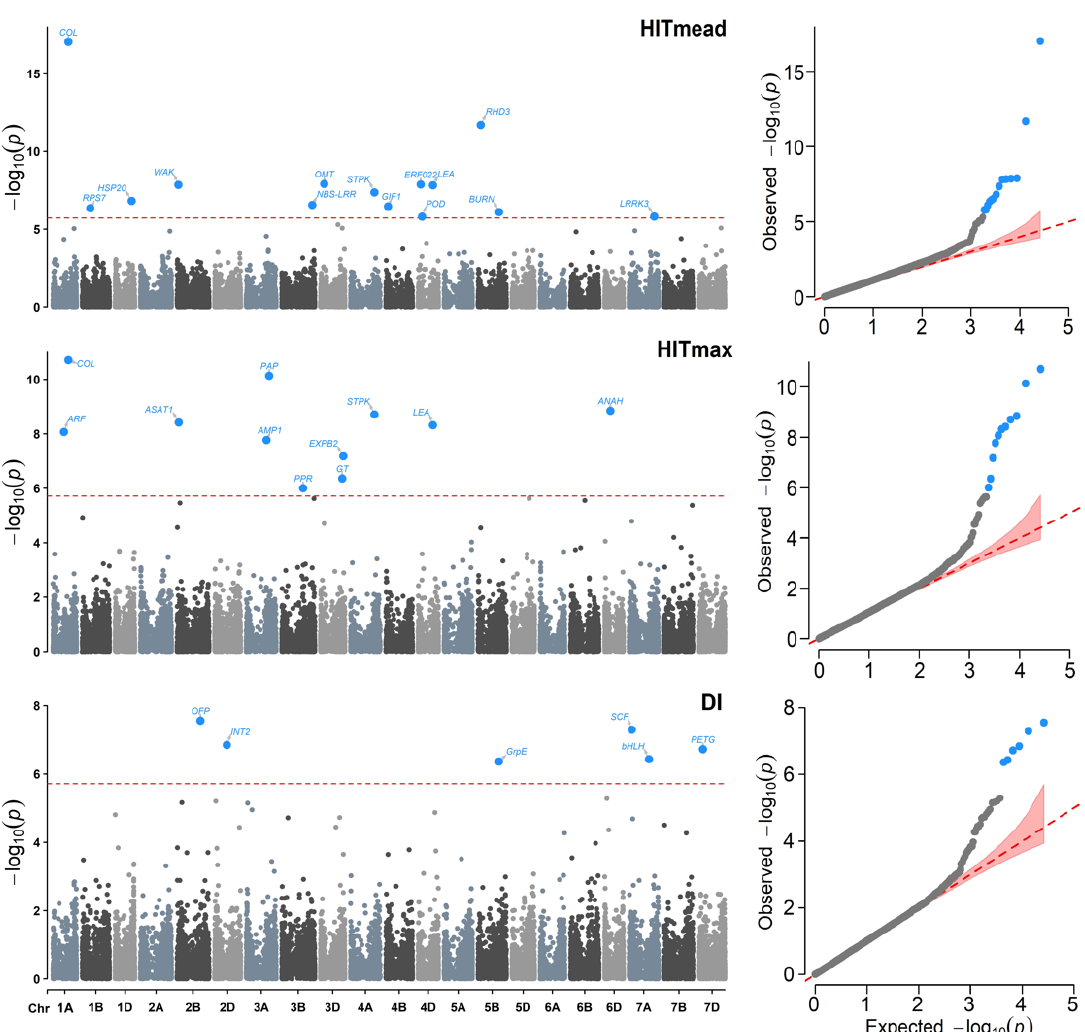
Figure 5. Manhattan ( left ) and QQ ( right ) plots for Genome–environment Association (GEA) analyses with the FarmCPU model and the variables: heat index of the mean temperature (HITmead), heat index of the maximum temperature (HITmax), and drought index (DI) in 990 landraces of bread wheat and 26,064 SNPs markers. The red dashed horizontal line marks the -log 10 ( p -value) threshold after Bonferroni correction for multiple comparisons. The proteins associated with the significant SNPs are labeled in each graph.